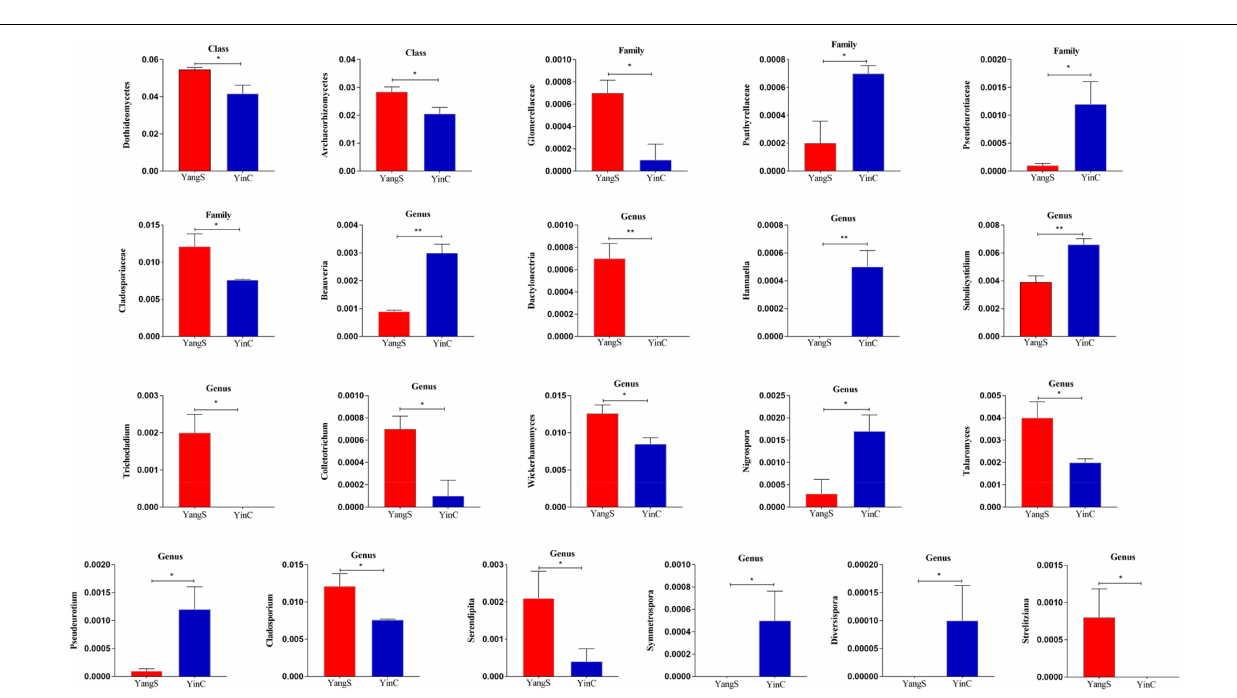
Frontiers in Microbiology | www.frontiersin.org July 2022 | Volume 13 | Article